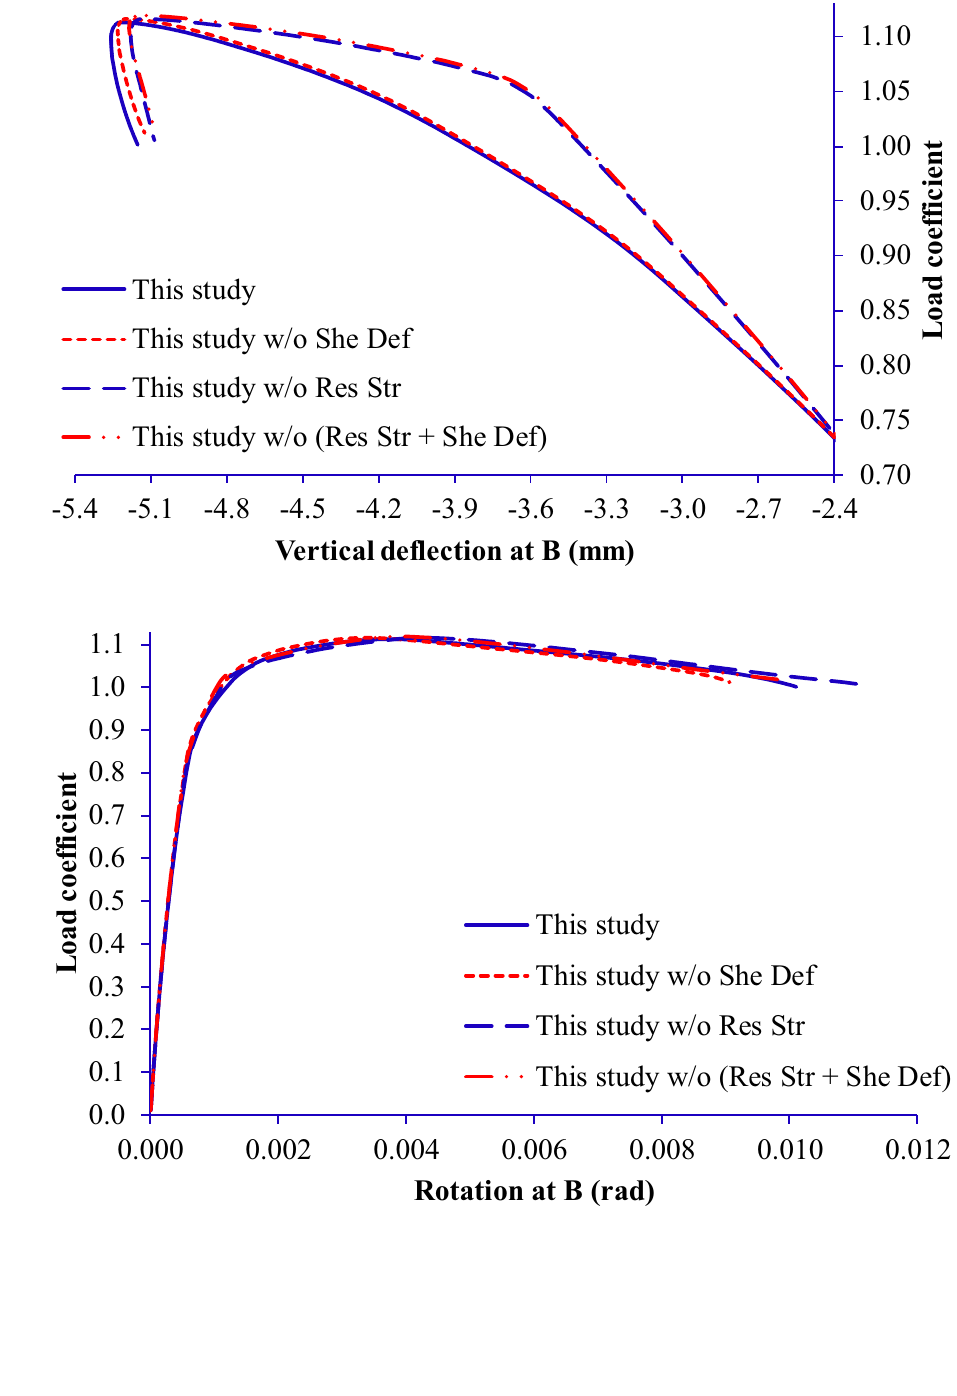
Fig. 20 Load-vertical deflec- tion relationship at B of six- story frame